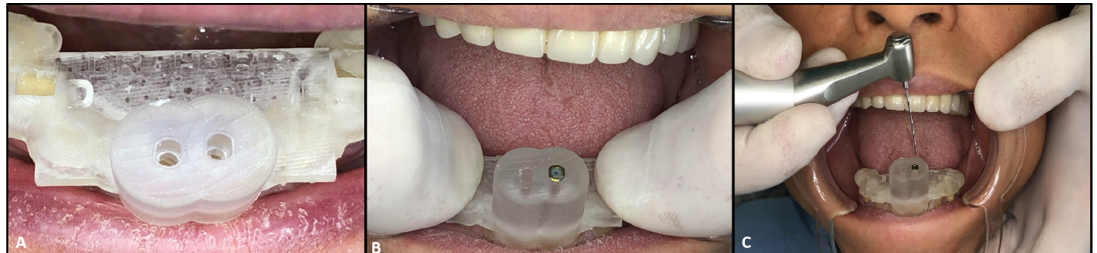
Figure 4. ( A ) Endodontic guide positioning. ( B ) Testing stability and adaptation. ( C ) Drilling through the endodontic guide and sleeve; drill of 0.75 mm diameter (FFDM Pneumonat, Bourges, France).